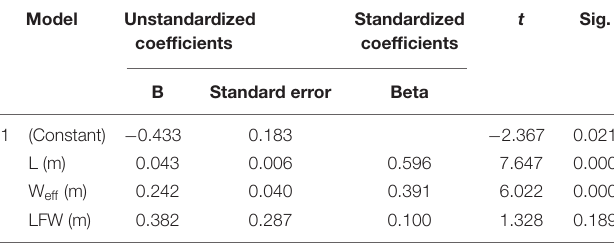
TABLE 4 | Regression coefficients for three independent variables.